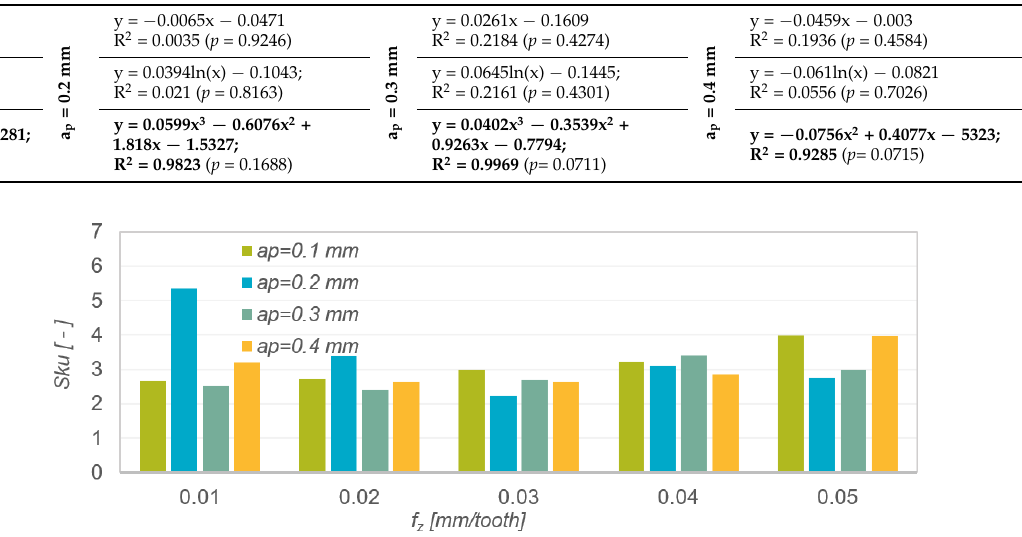
Figure 7. Results of measurements of the roughness parameter Sa as a function of feed per tooth f z and depth of cut a p . Table 7. Results of mathematical modelling of the Sku parameter as a function of the feed rate for different values of the depth of cut (regression functions y = Sku(f z ); f z = x with the coefficient of determination R 2